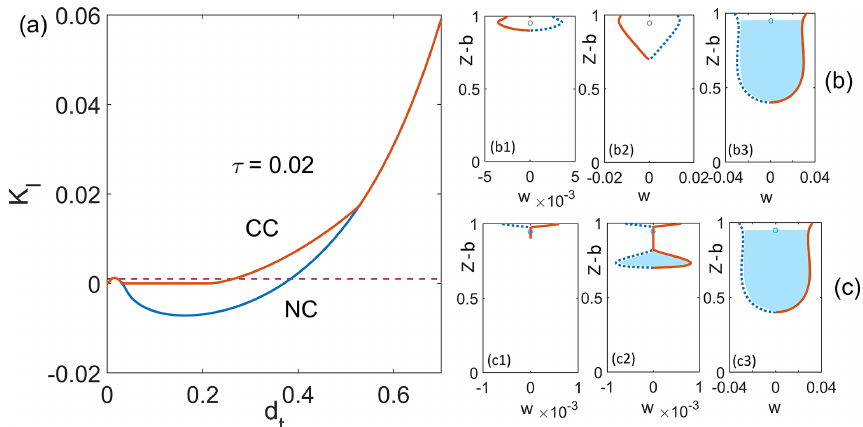
Figure 4. (a) The equivalent of Fig. 3 for the case of fixed water level η , with parameter values η = 0 . 04 and τ = 0 . 02, using the same plotting scheme as Fig. 2. Rows (b) and (c) show the crack opening and water-filled parts of the cracks for d t = 0 . 1 (b1, c1) , d t = 0 . 3 (b2, c2) and d t = 0 . 6 (b3, c3)